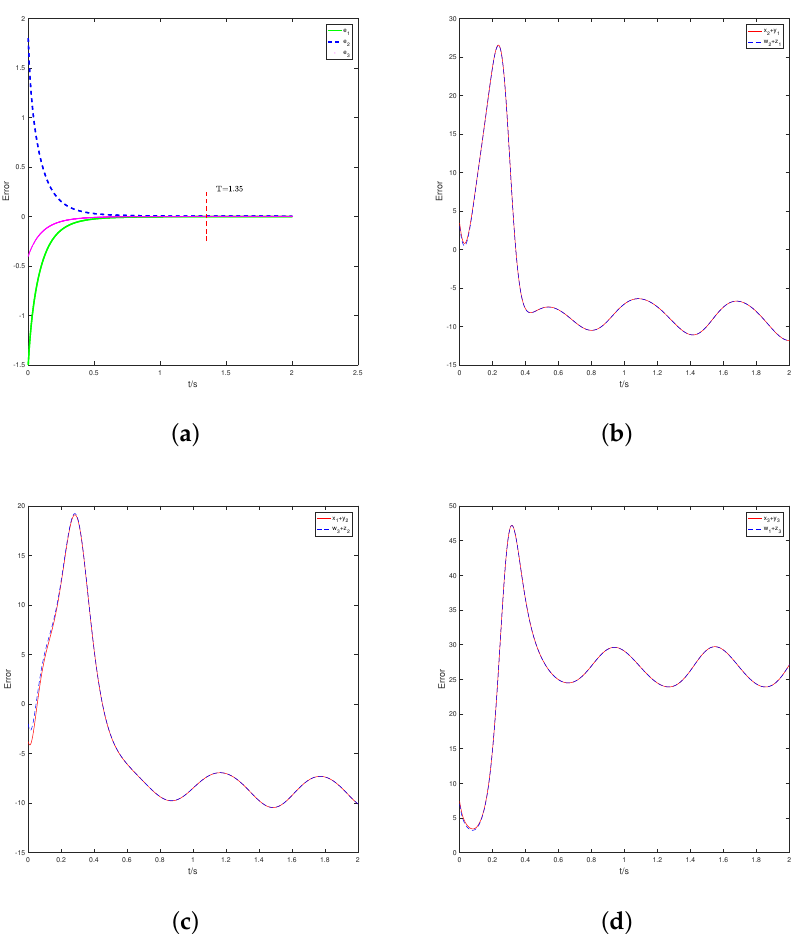
Figure 3. ( a ): The time response of synchronization error of Switch 2, ( b – d ): The state trajectories of Switch 2.